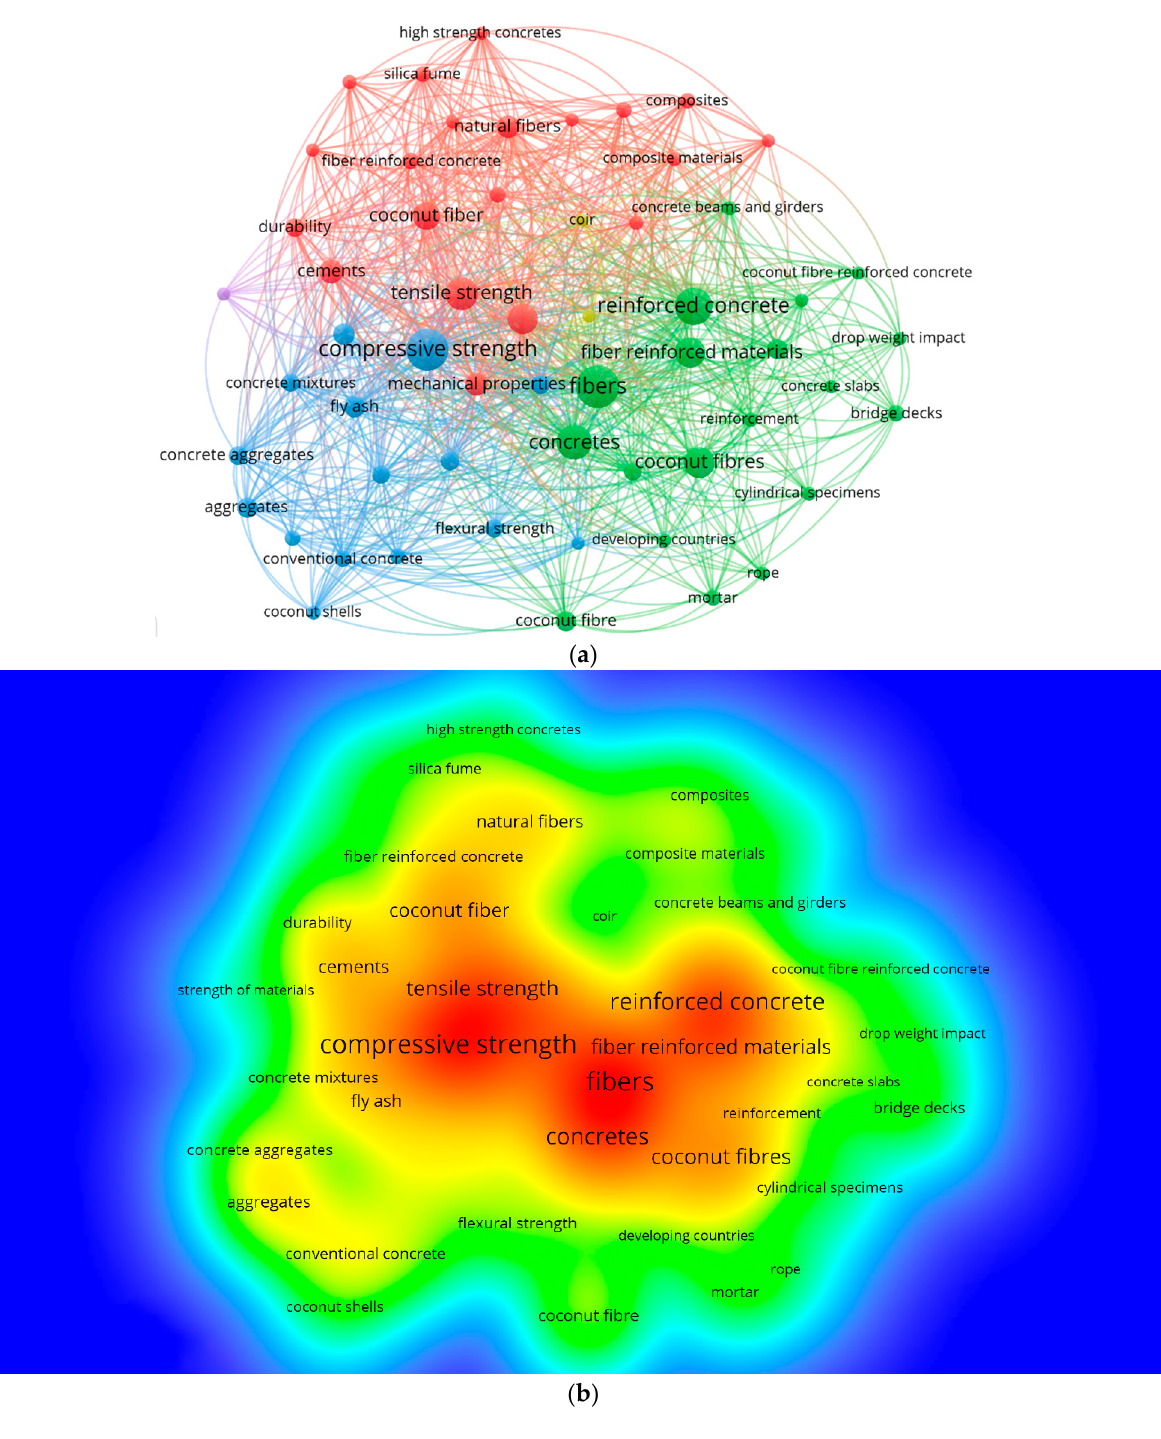
Figure 8. Keywords analysis: ( a ) Scientific visualization. ( b ) Density visualization .